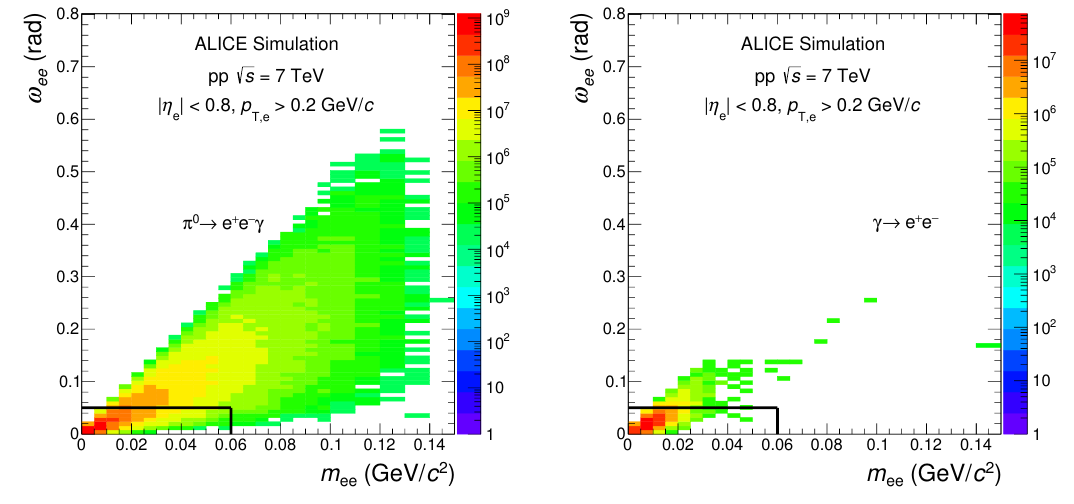
Figure 2 . (Colour online) Opening angle vs invariant mass of e + e (cid:0) pairs from (cid:25) 0 Dalitz decays (left) and from photon conversions (right) in MC simulations after the single track selection criteria. The lines indicate the pre(cid:12)lter